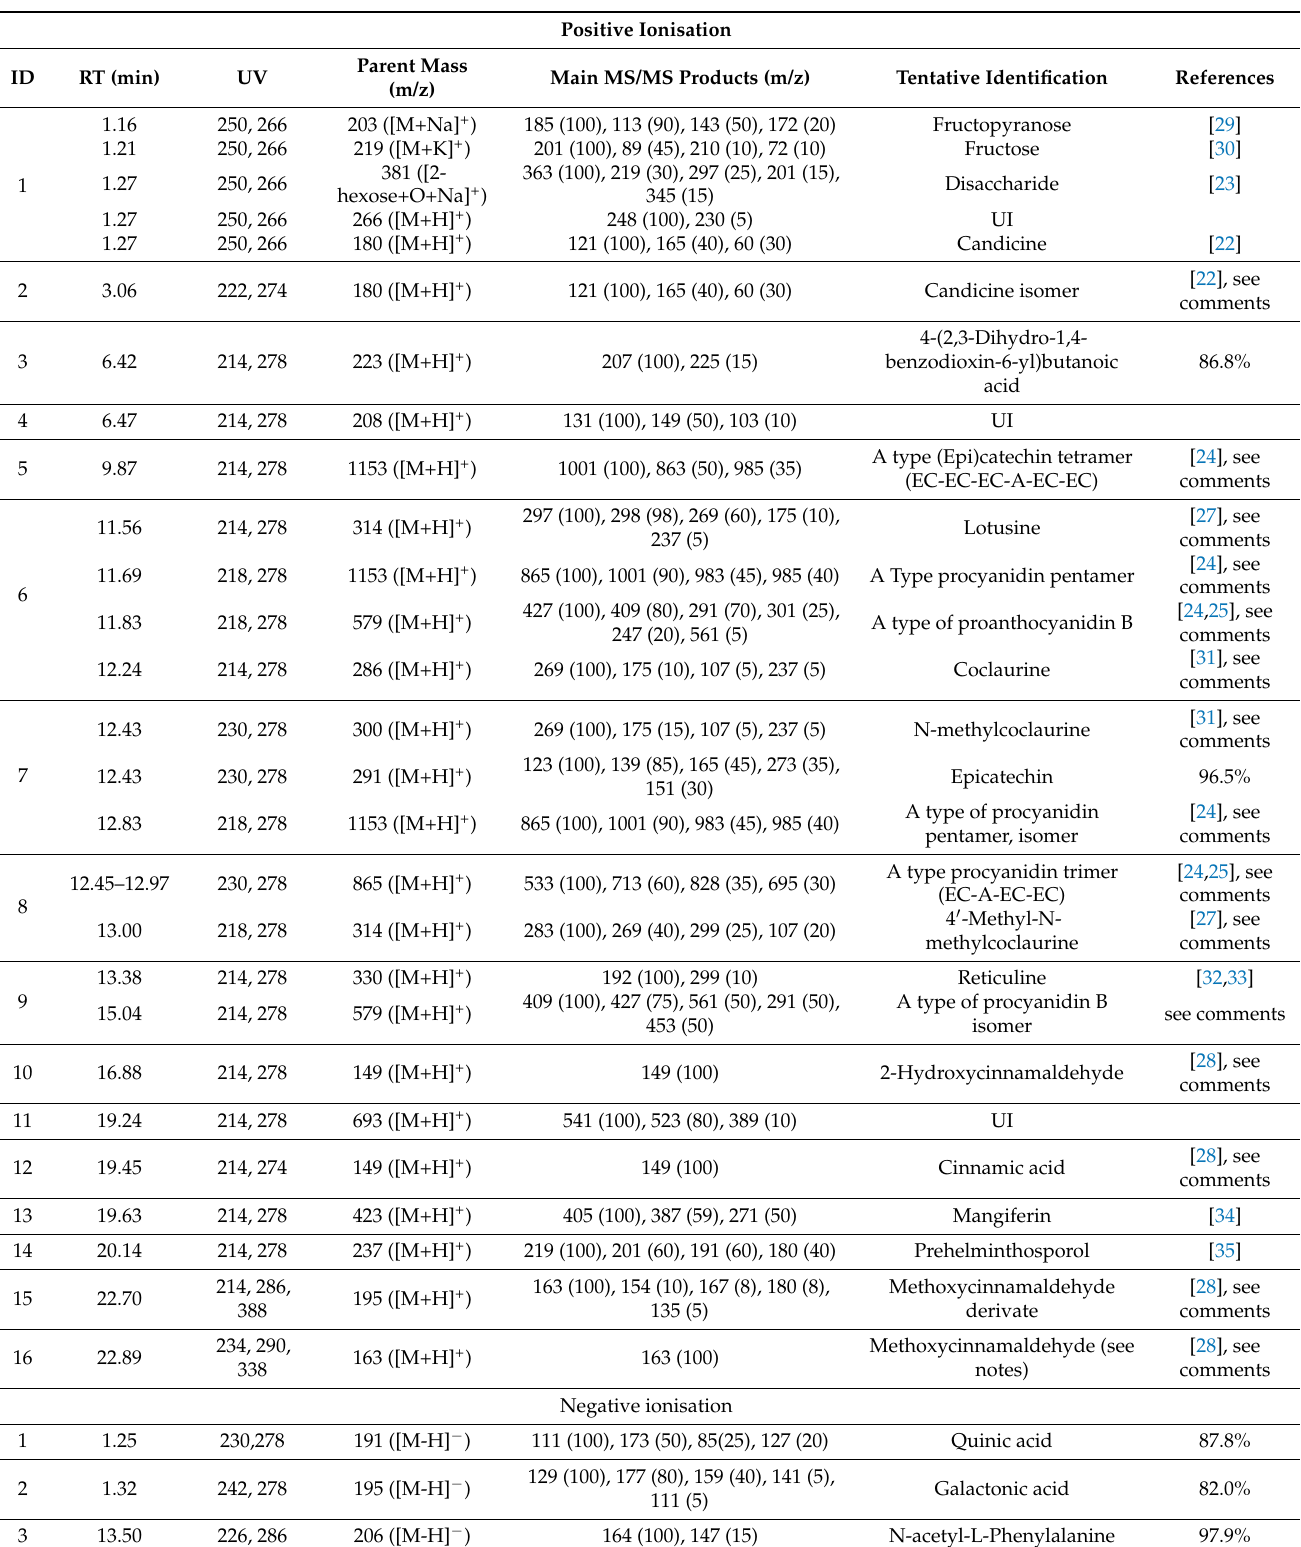
Table 5. Metabolites identified in Cinnamomum sp. by HPLC-ESI-MS/MS in positive and negative ionisation